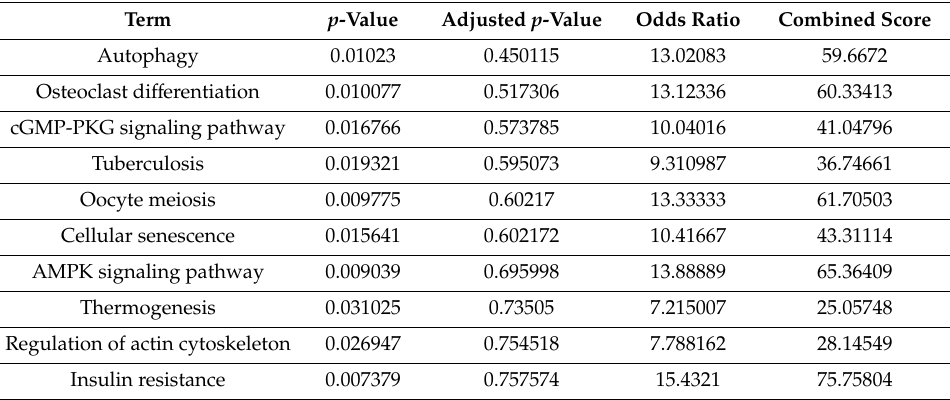
Table 5. Top 10 enriched KEGG pathways in blood from ASD